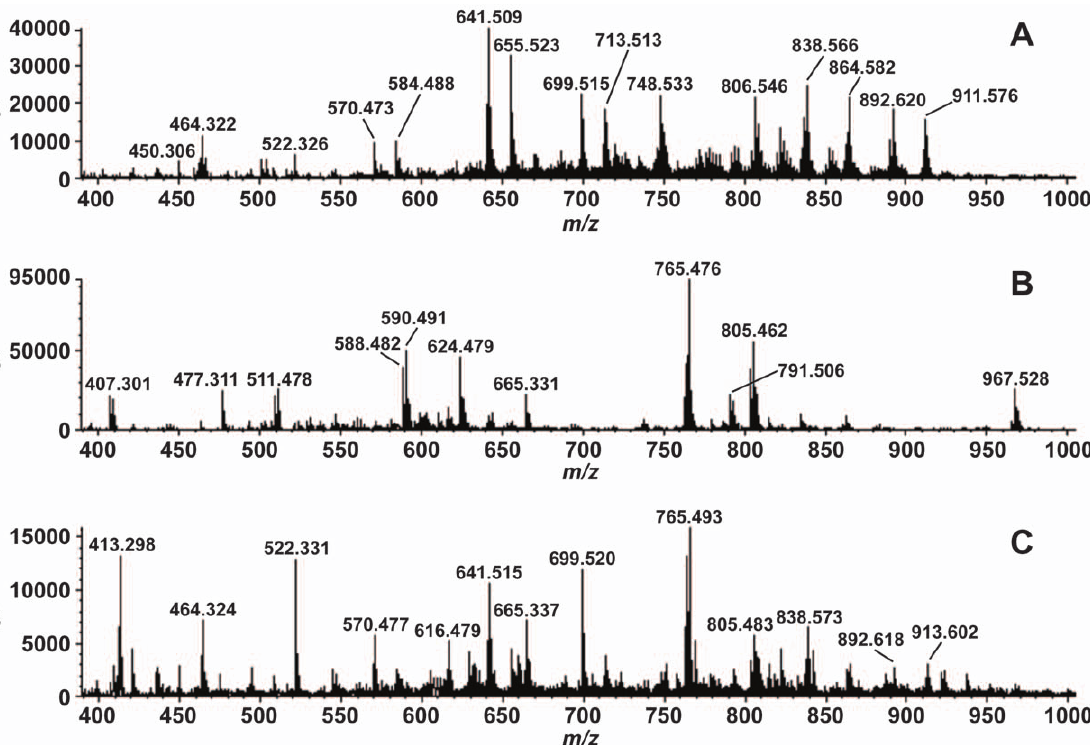
Figure 2. Negative-ion electrospray ionization mass spectrometry of total lipid extracts from A.pallida and Symbiodinium . Total lipid extracts from aposymbiotic A. pallida (Panel A), Symbiodinium FLAp1AB (Panel B), and A. pallida in symbiosis with Symbiodinium (Panel C) were analyzed by direct infusion into a quadrupole time-of-flight mass spectrometer and analyzed in the negative mode. The spectra from m/z 400–1000 are shown.